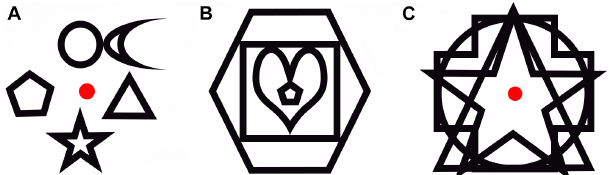
Figure 2. Example of the shapes presentation on each image during simultanagnosia assessment [50]: ( A ) adjacent, ( B ) embedded, and ( C )